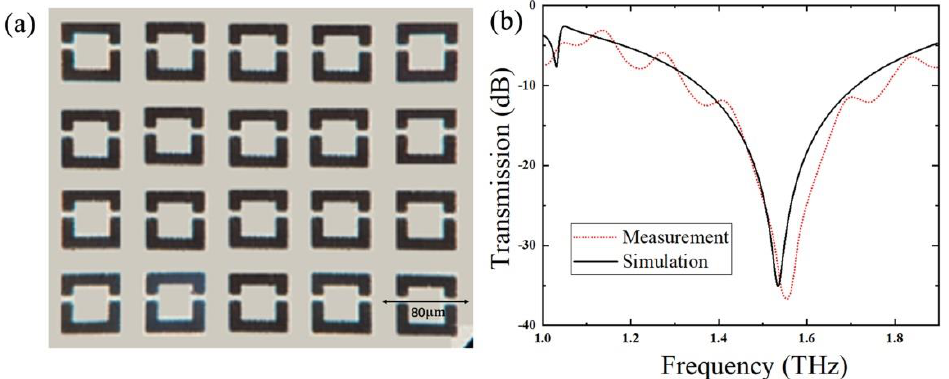
Figure 4. ( a ) Micrograph of the fabricated square ASR array metamaterial sensor; ( b ) THz transmis- sion spectra of the sensor from the simulation and the experimental measurement.